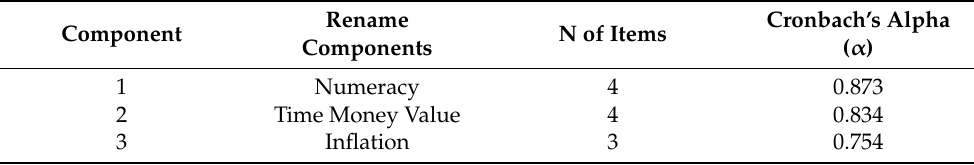
Table 3. Internal Reliability for Financial Literacy